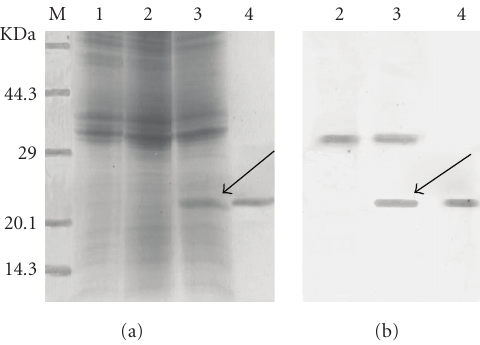
Figure 1: SDS-PAGE and Western blotting analysis of BmrhGH expressed in B. mori pupae. The silkworm pupae were infected with the recombinant virus vBmrhGH or wild type BmNPV. The supernatant solution of pupae homogenate was prepared at 120 hours after infection and electrophoresed through 15% SDS- PAGE (a) and identified by Western blotting analysis with anti- hGH antiserum (b). Lanes: M, Low molecular weight marker; 1, supernatant solution of normal pupae; 2, supernatant solution of pupae infected by wild type BmNPV; 3, supernatant solution of pupae infected by recombinant virus vBmrhGH; 4, standard hGH. Arrow indicates BmrhGH protein.